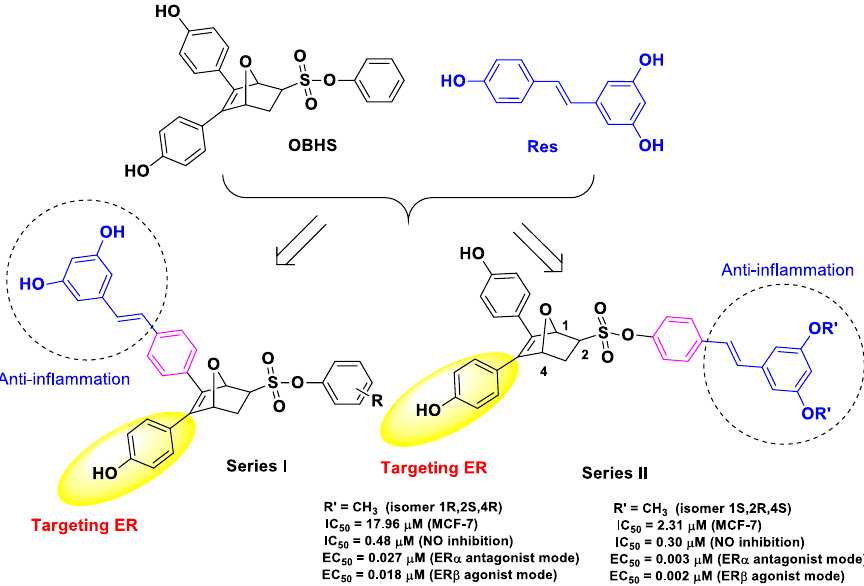
Figure 16. Structure, activity, and SAR insights of the most potent conjugated hybrid derivative developed by Ning et al. [52].